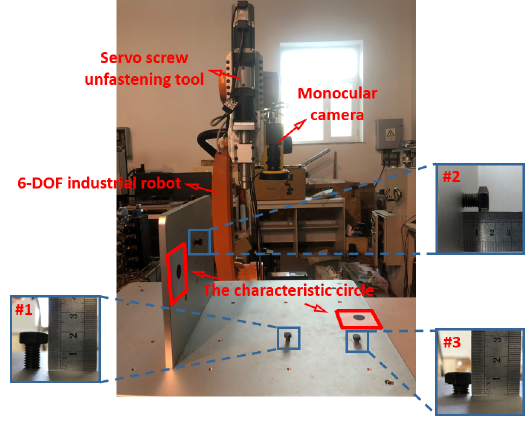
Figure 21. A hexagonal screw-removal